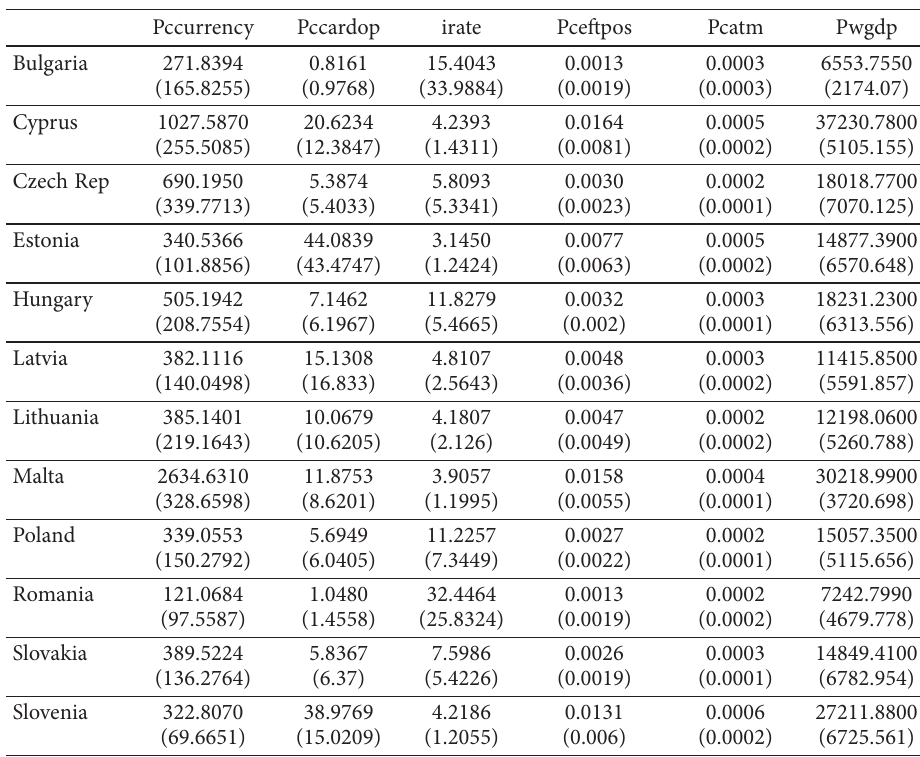
Table A.1. Descriptive statistics by country